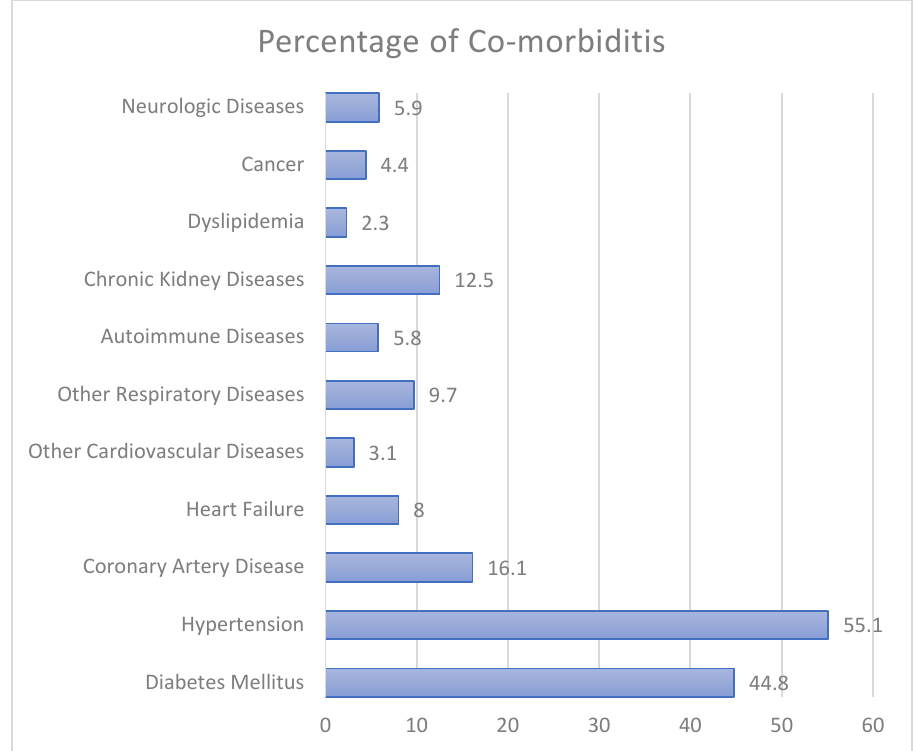
Figure 1. Comorbidities among COVID-19 patients ( n = 745).